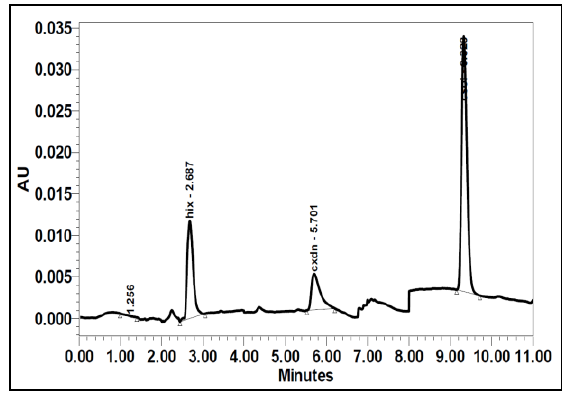
Fig. 6 . HPLC chromatogram of Cyteal ® douche showing simultaneous separation of 2.50 µg/mL HEX, 12.50 µg/mL CHX & 7.50 µg/mL CSOL at a timed wavelength of 265, 260 & 230 nm; respectively.